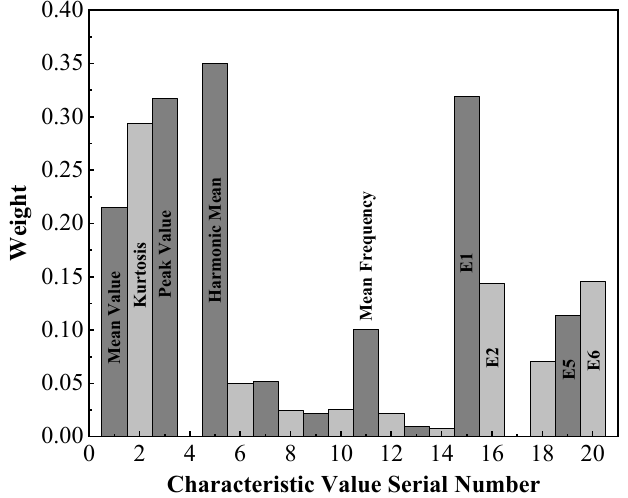
Figure 6. Weight distribution of original feature parameters .